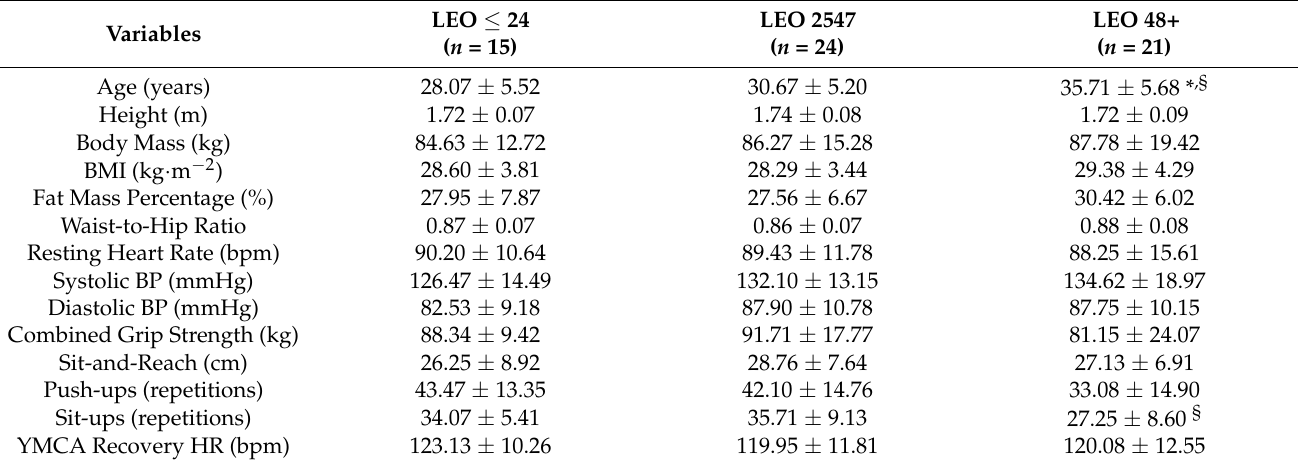
Table 2. Descriptive data (mean ± SD) for age, height, body mass, body mass index (BMI), fat mass percentage, waist-to-hip ratio, resting heart rate, systolic and diastolic blood pressure (BP), combined grip strength, sit-and-reach, push-ups, sit-ups, and recovery heart rate (HR) from the YMCA step test in law enforcement officers who had spent ≤ 24 months (LEO ≤ 24), 25–47 months (LEO 2547), and ≥ 48 months (LEO 48+) working in